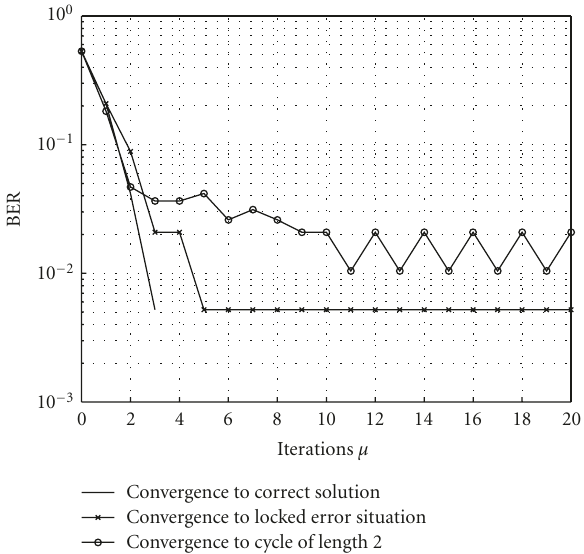
Figure 4: Possible convergence behavior for IHDIC with parallel ( E b / N 0 ) = 15dB, synchronous DS-CDMA update for 10 log 10 transmission over an AWGN channel with V = 64 users employing 8PSK and complex-valued random spreading sequences with spreading factor L =